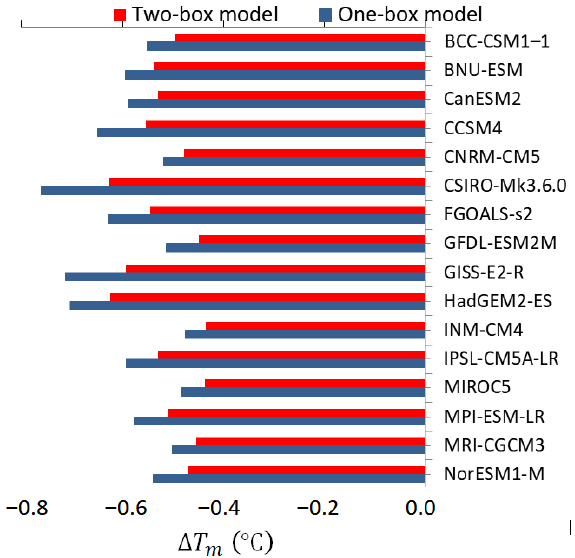
Figure 2. Climate system response Δ𝑇 𝑚 (℃) to volcanic aerosol radiative forcing obtained by different EBMs with parameters listed in Table 1. EBMs with parameters listed in Table 1.